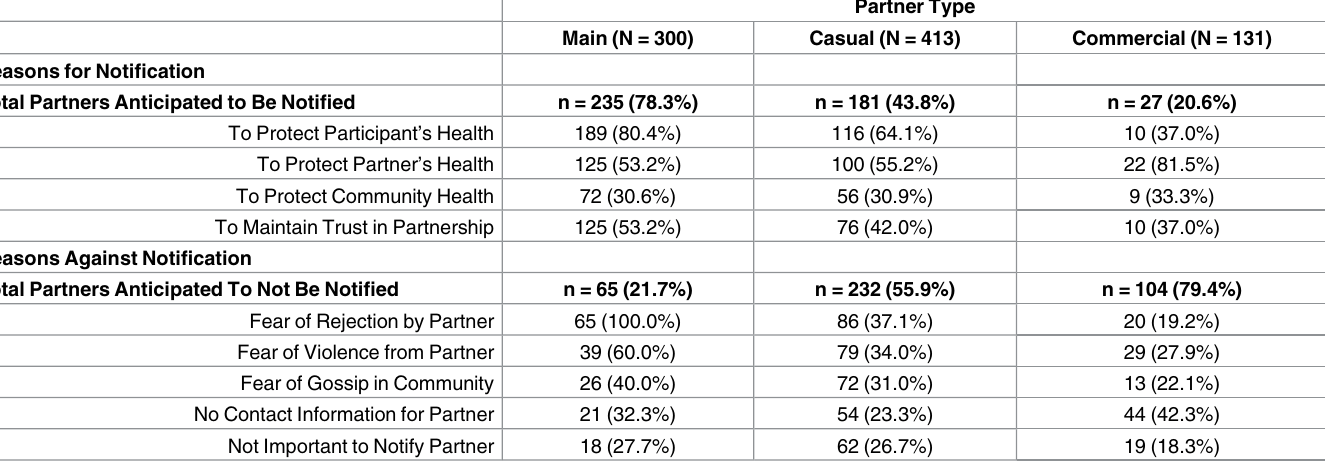
Table 2. Incentives and Barriersto Partner Notification (By Partner Type) Among MSM/TW Recently Diagnosed with HIV and/or STD; Lima, Peru